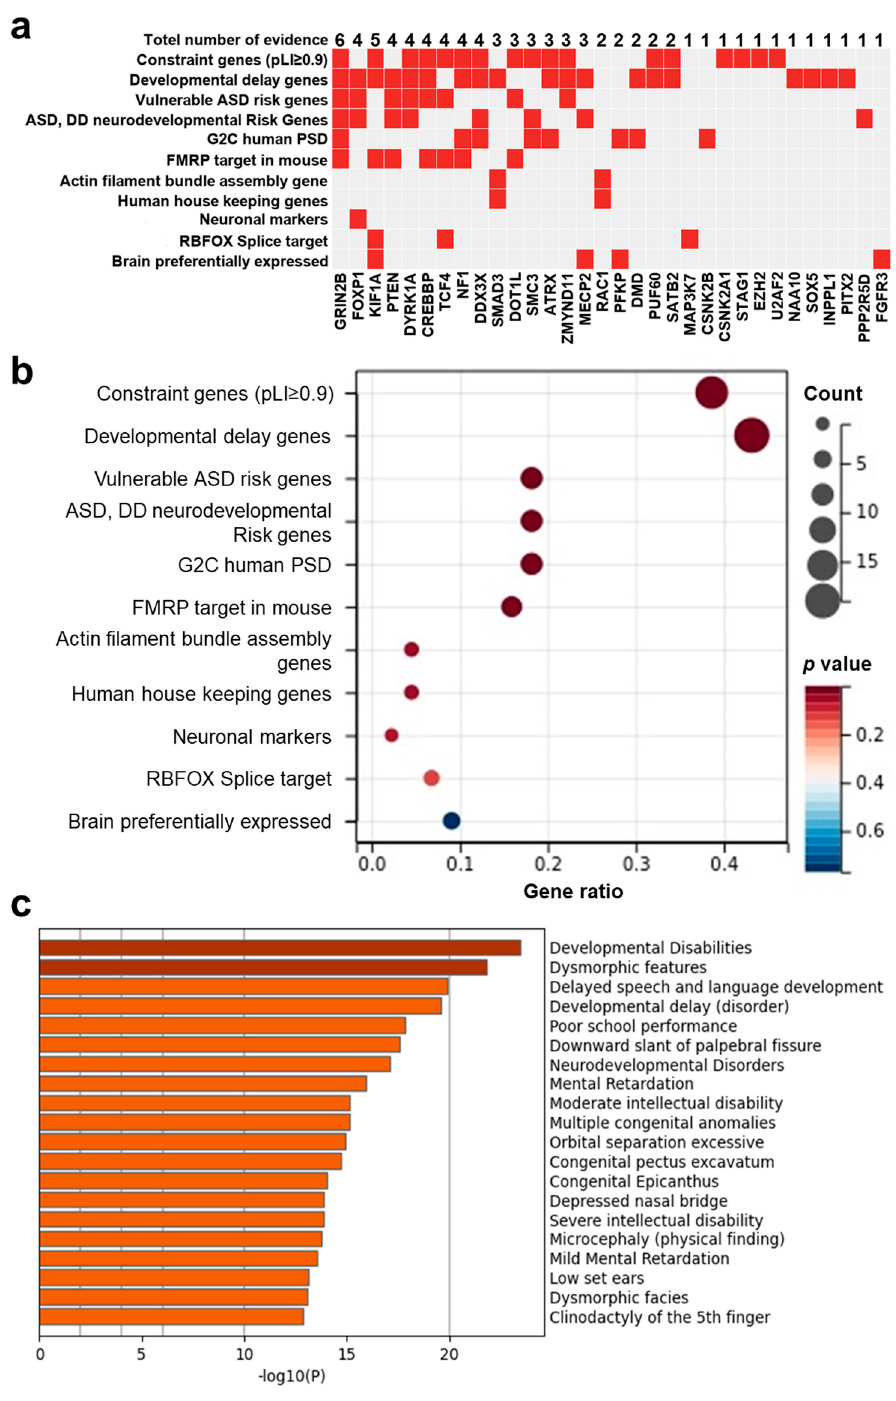
Figure 3. The pathogenicity of DD candidate genes was identified in the present study. ( a , b ), Inte- grative analysis of the potential pathogenicity of DD candidate genes ( a ), DD-related pathogenesis gene set enrichment analysis of candidate genes ( b ), and eleven independent sources of evidence were used to analyze DD candidate genes. Gene ratio is the number of differential genes enriched in a particular gene set to the total number of candidate genes. ( c ), DisGnNET enrichment analysis of DD candidate genes.